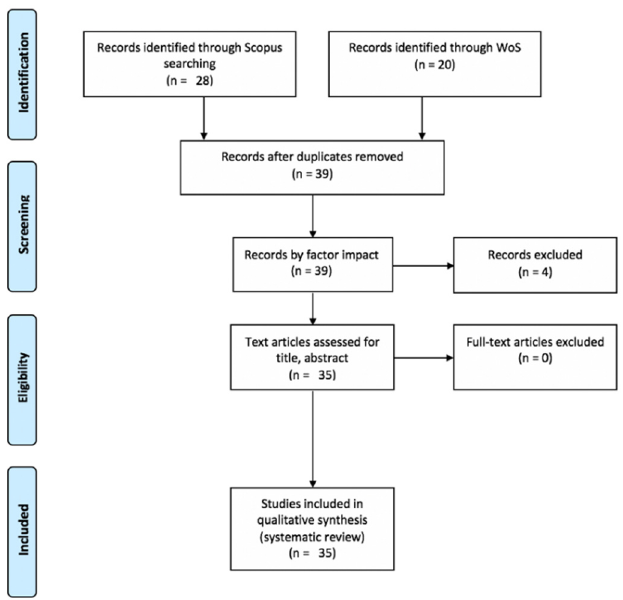
using the Prisma method [31].